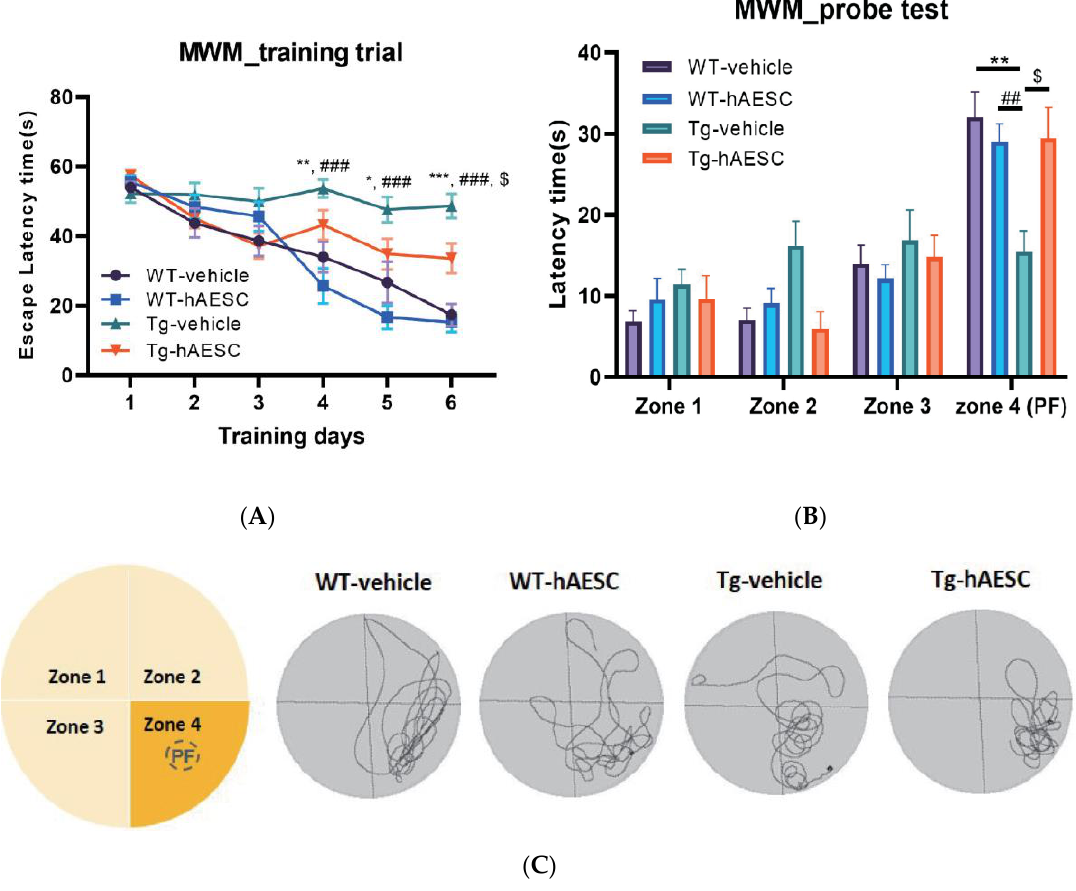
Figure 1. Experimental schemes. ( A ) Experimental scheme for the behavioral tests and intracerebral injections. ( B ) Stereotaxic coordinates of the intracerebral injection sites. The red arrows indicate the injected site of hAESCs (or